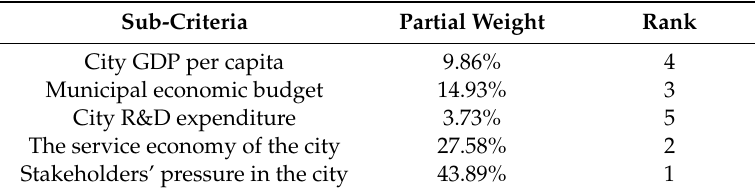
Table 10. Sub-criteria relative weight and rank of socioeconomic context of the city.